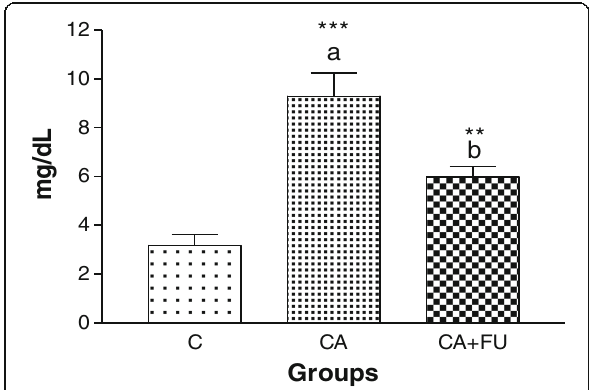
Fig. 1 Effect of treatment with cyclosporine and fucoidan on serum creatinine level. C control group, CA cyclosporine group, CA + FU cyclosporine + fucoidan group. The significant difference between groups was judged by ANOVA as follows: a = significance difference between C and CA, b = significance difference between CA and CA